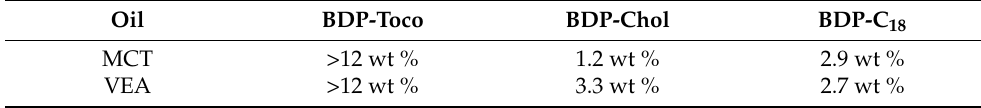
Table 2. Solubility of three BODIPY conjugates in oils (at